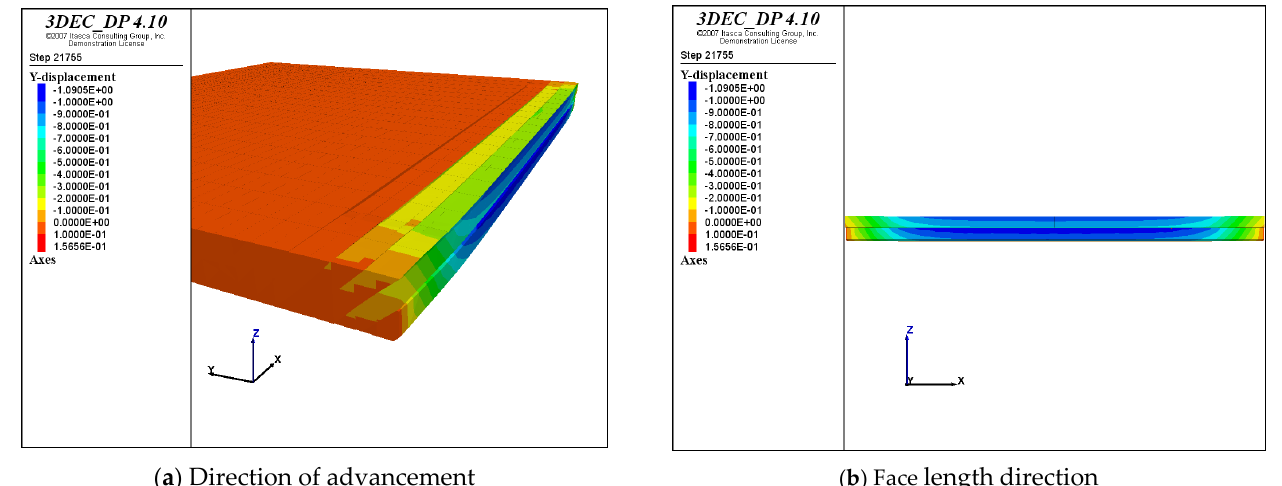
Figure 22. Y-displacement nephogram ( α sj = 135 ◦ , d = 2